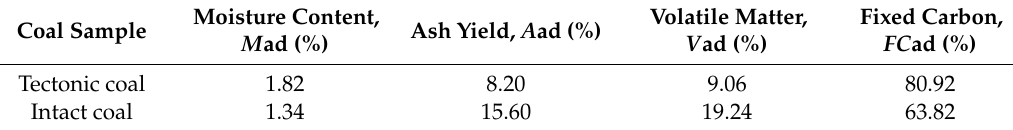
Table 1. Proximate analysis of coal samples.